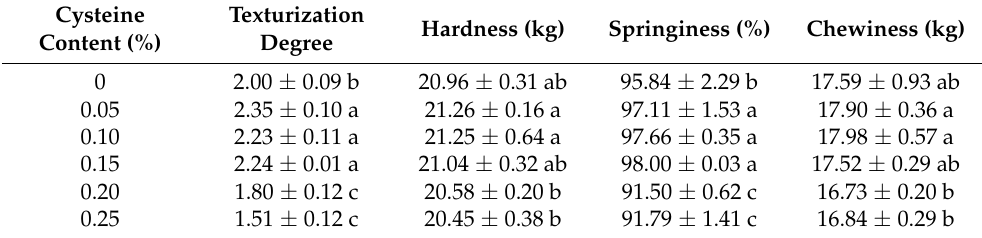
Table 2. Effects of cysteine content on the texturization degree and texture properties of the extrudates. Cysteine Content (%)